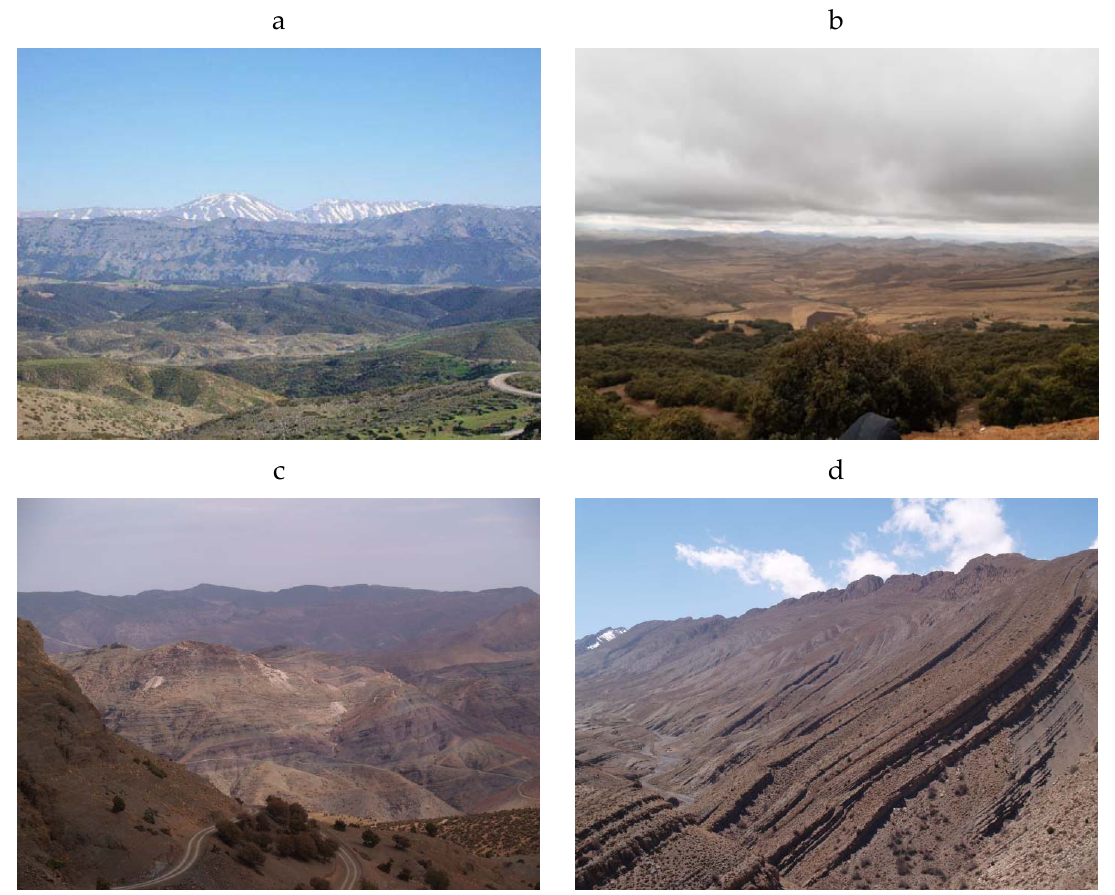
Figure 11. Observation of ( a ) the western side of the Folded Middle Atlas reliefs, in Northeast Middle Atlas, and ( b ) the relief of the Tabular Middle Atlas, ( c ) The Precambrian formation of the Lit-de-vin series and ( d ) Cambro-Odovician limits of the Bou Azzer inlier in the Central Anti-Atlas region.